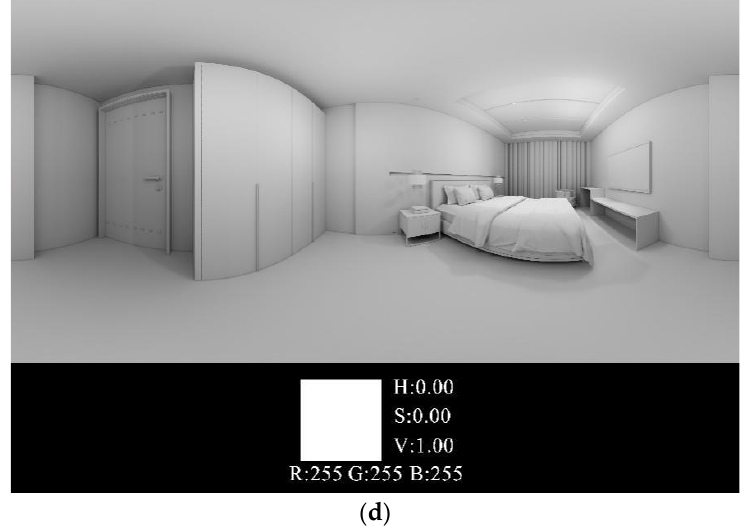
Figure 2. Experimental simulations and relevant parameters: ( a ) gray schemes and relevant parameters; ( b ) blue schemes and relevant parameters; ( c ) yellow schemes and relevant parameters; ( d ) colorless scheme and relevant parameters.